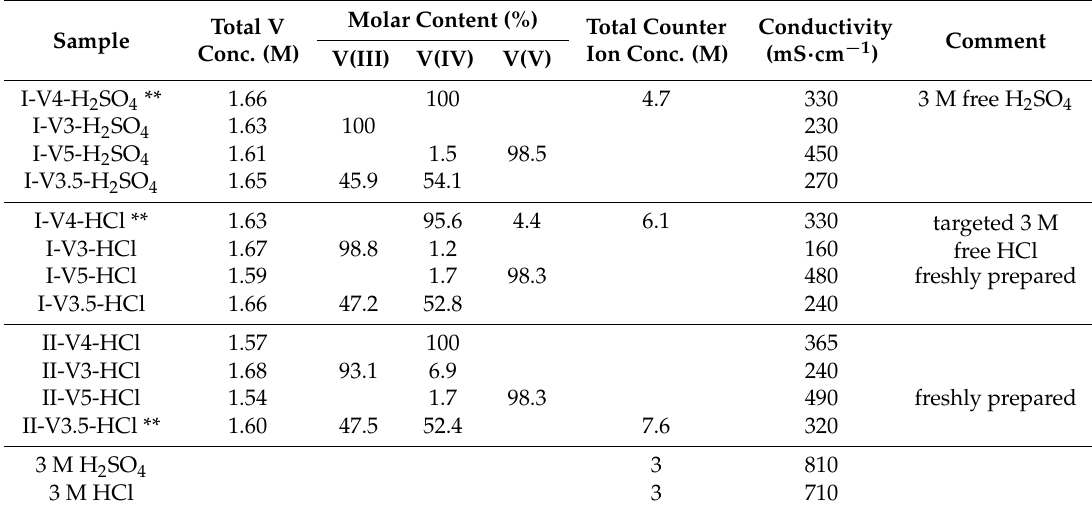
Table 1. Denotations and analysis data for vanadium electrolyte samples used in the study. Total Sample